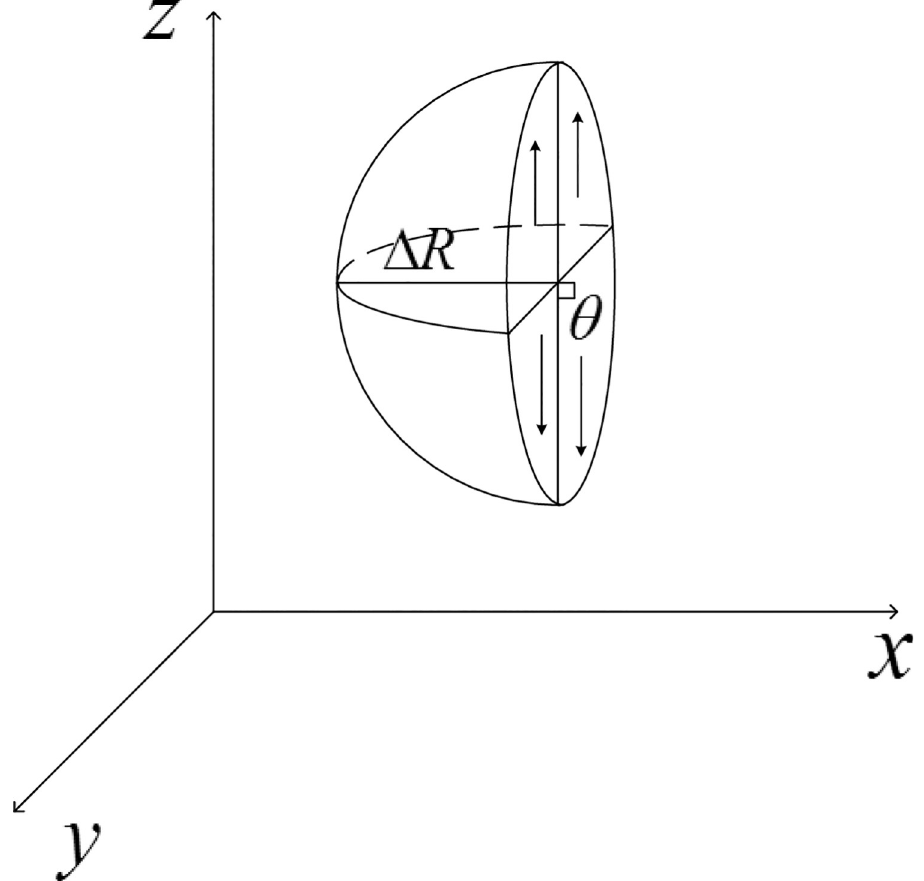
Fig 2. One-dimension frozen soil moisture and heat coupling